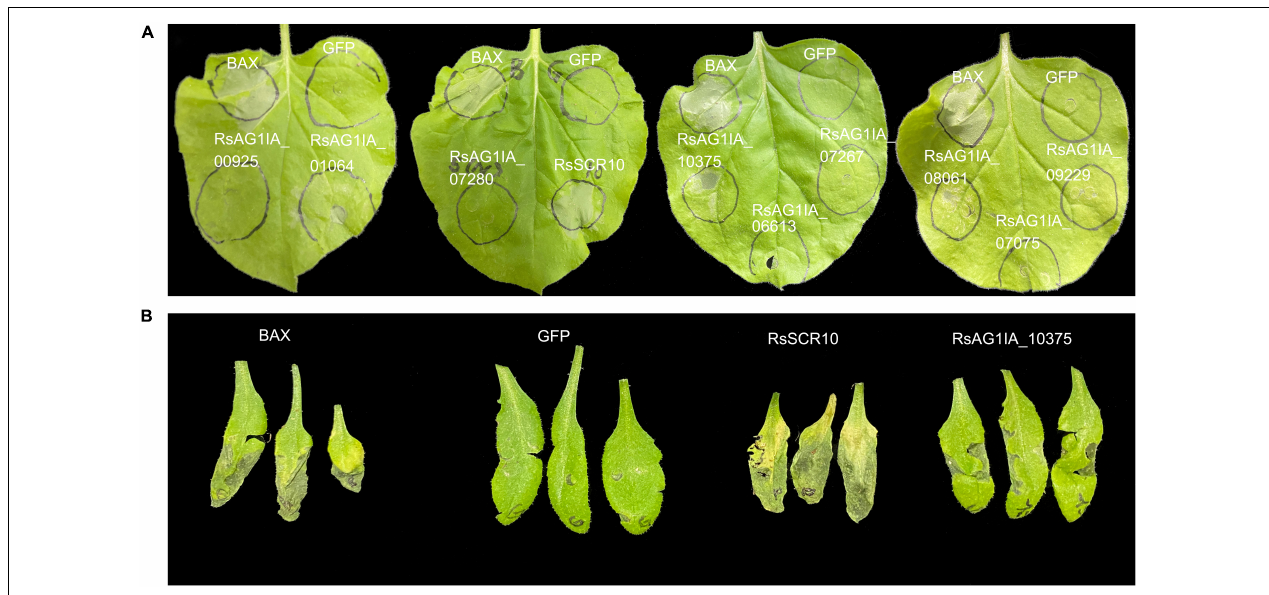
FIGURE 1 | Induction of cell death in leaves by agroinfiltration of RsSCR10. (A) Transient expression assays of 10 putative R. solani effectors revealed that two candidate effectors could cause cell death or mottling symptoms in N. benthamiana leaves. GFP and BAX constructs were infiltrated as a negative and positive control, respectively. Representative photos were taken 4 days postinfiltration. (B) Cell death in Arabidopsis leaves. Data are the means from three independent